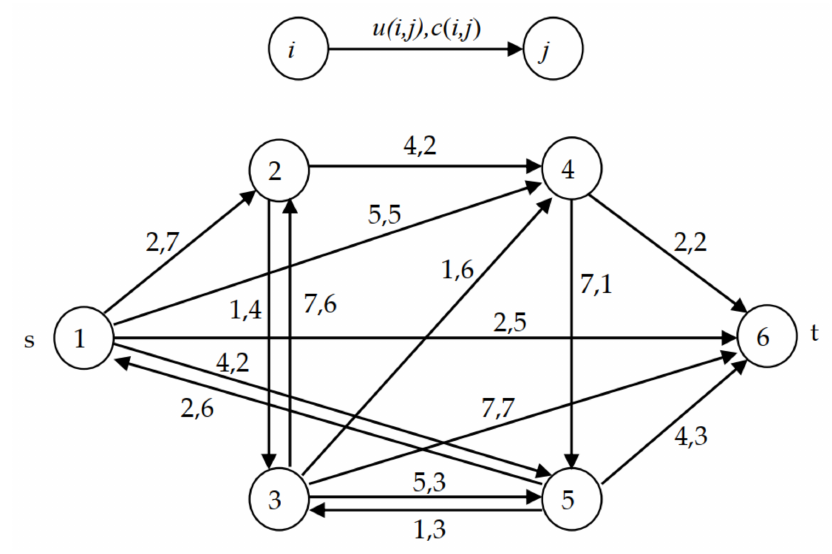
Figure 2. Network generated with AGRFN.